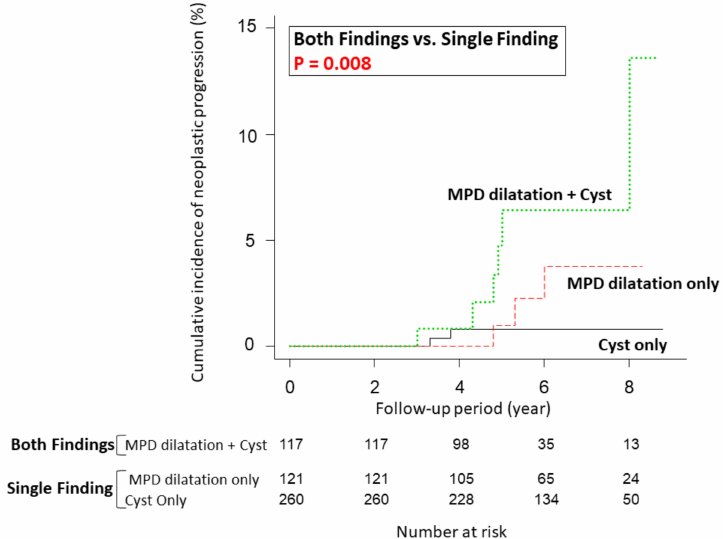
Figure 2. Comparison of the cumulative incidence of neoplastic progression in terms of MPD dilatation ( ≥ 2.5 mm) and the presence of pancreatic cysts ( ≥ 5 mm) at initial surveillance. The incidence at 5 years was 6.4% in patients with MPD dilatation ( ≥ 2.5 mm) and cysts, 1.0% in patients with only MPD dilatation, and 0.8% in patients with only pancreatic cysts. MPD, main pancreatic